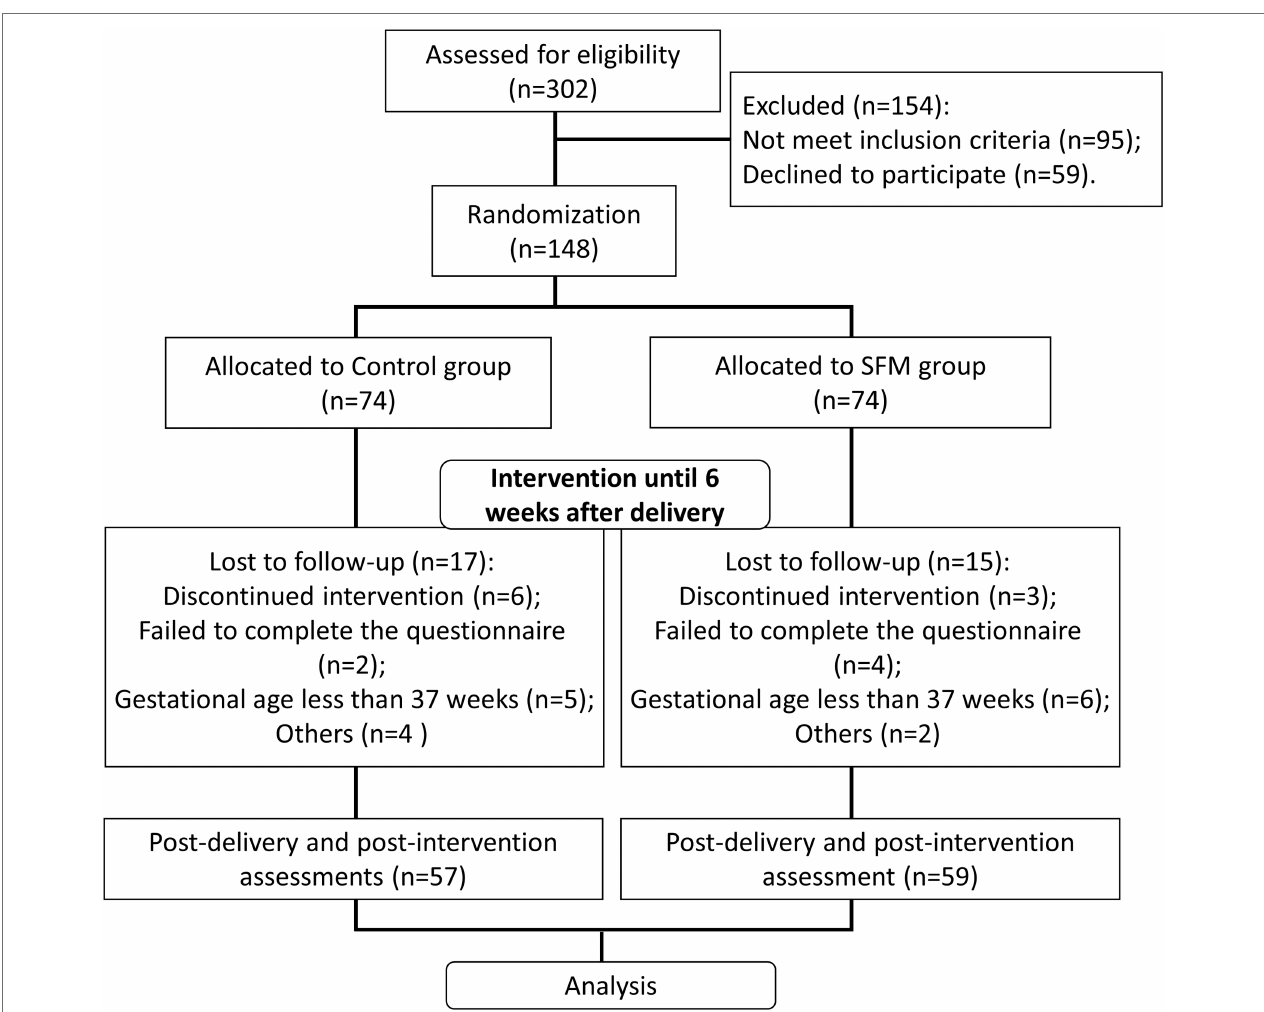
FIGURE 1 | Research framework of this study. SFM, solution-focused